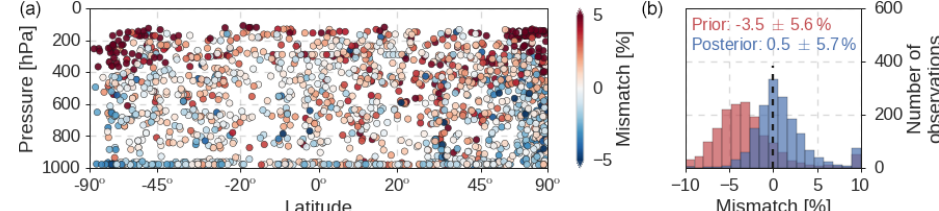
Figure 7. The mismatch of simulated minus observed MCF mole fractions from the HIPPO and ATom aircraft campaigns. Differences are shown relative to the observed mole fraction. We aggregated results from the HIPPO 1, HIPPO 3–5, and ATom 2 and 3 campaigns. (a) A plot of the model–measurement mismatches for each of the aircraft samples. Modeled mole fractions were sampled from the posterior REF simulation. (b) A probability-density distribution of the prior (red) and posterior (blue) mismatches in the REF inversion. Numbers denote the median mismatch and its standard deviation. Mismatches that fall outside the range on the x axis were added to the outermost